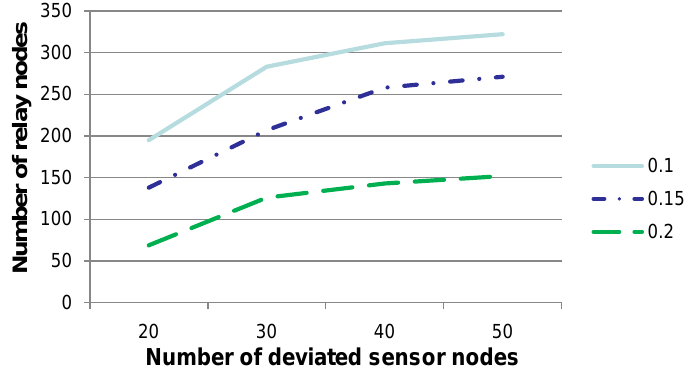
Figure 3. Comparison of the number of relay nodes when the number of sensor nodes (denoted cnt ), whose sensory data deviate from a normal sensing range, is set to various values. This figure shows that the number of relay nodes increases significantly when cnt is set to a relatively large value.